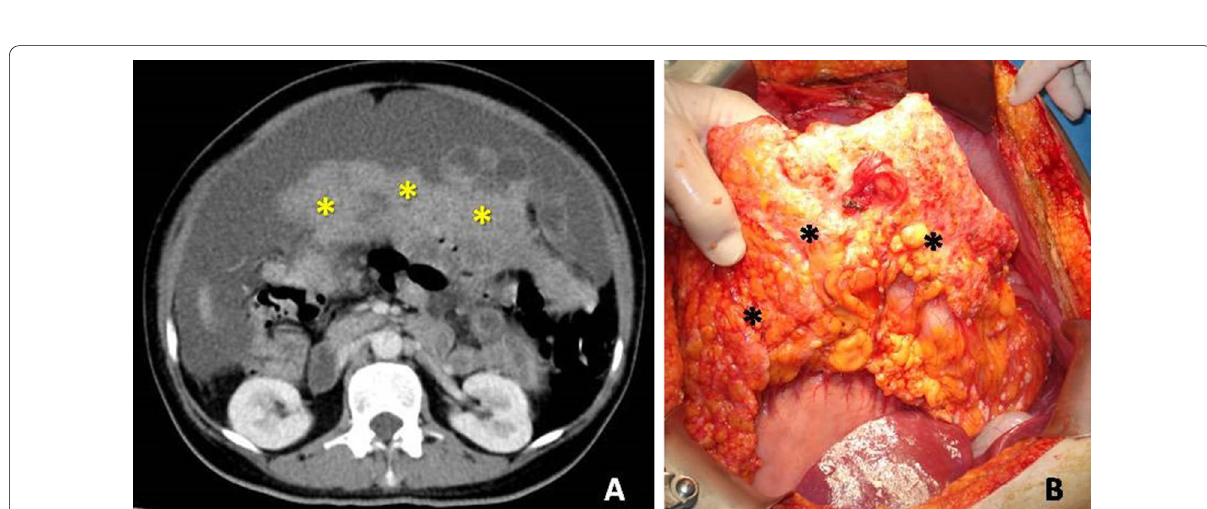
Fig. 8 a Contrast-enhanced CT image reveals massive infiltration of the greater omentum—“omental cake” (asterisks). b At surgery extensive infiltration of the omentum is demonstrated